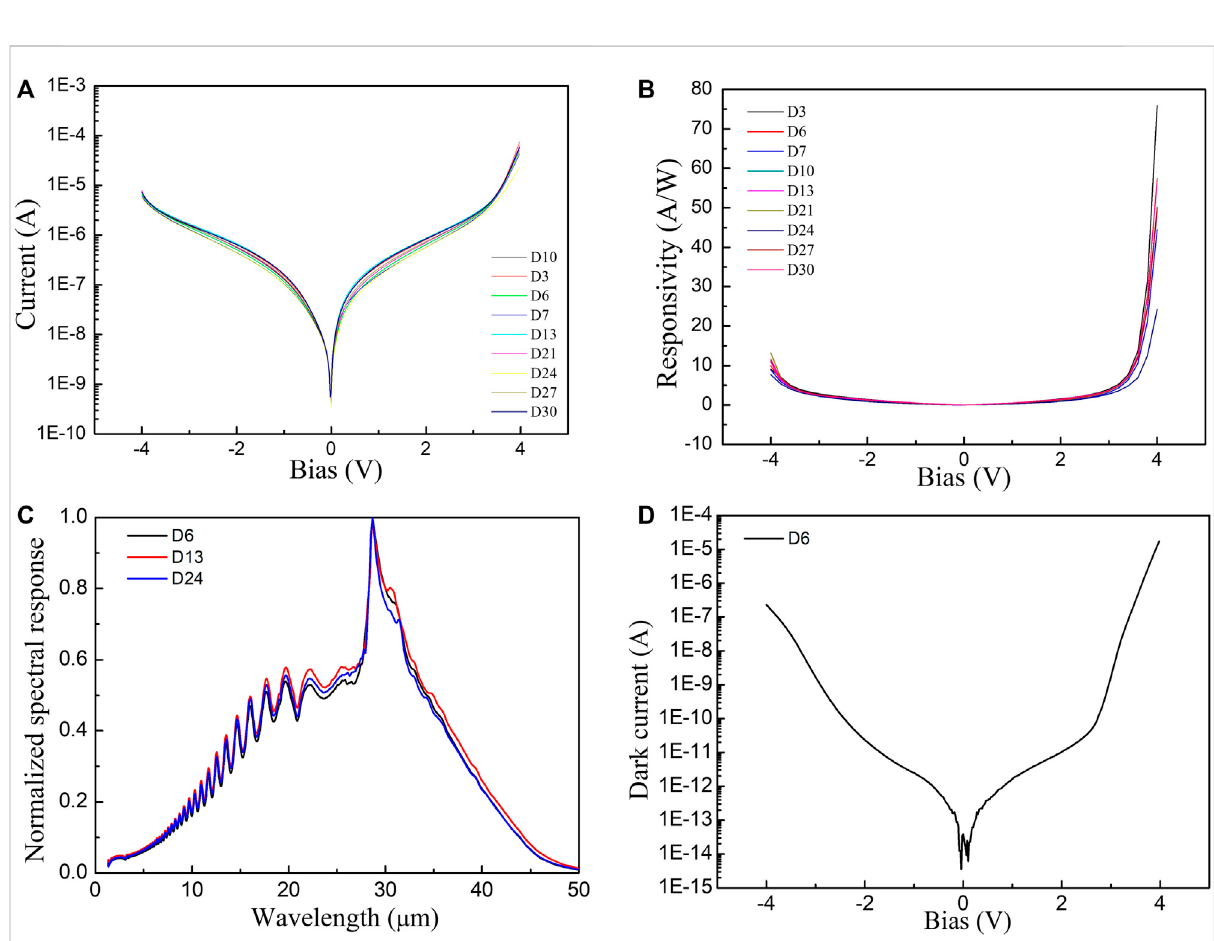
FIGURE 3 (A) TheI-VcurveofSi-basedBIBdetectordifferentpixelsunderdifferentbiases. (B) TheresponsivityoftheSi-basedBIBdetectordifferentpixels under different biases. (C) The spectral responsivity of Si-based BIB detector measured by Fourier Transform Infrared Spectrometer (D) The dark current of the Si-based BIB detector under different